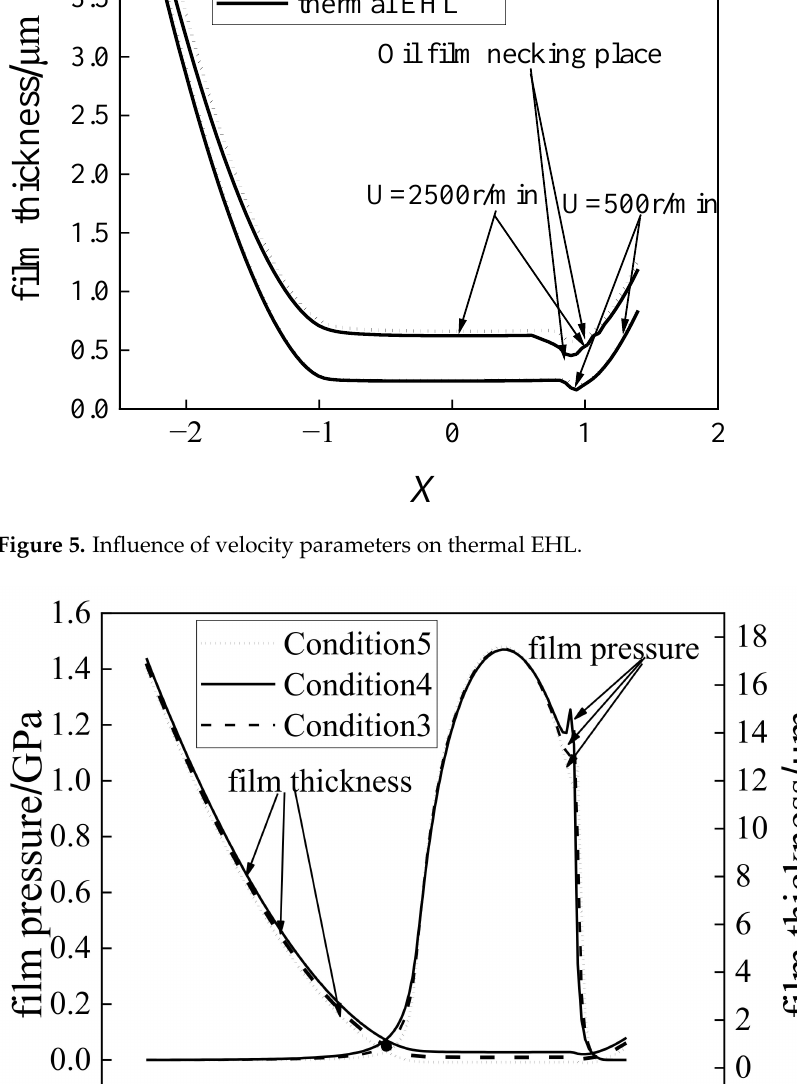
W = 12k N W = 3k N Figure 4. Effect of Radial Load on Oil Film Pressure Distribution. 4.1.2. Influence Analysis of Velocity Parameters Figure 5 shows the distribution of oil film pressure and film thickness in the X di- rection of the roller consisting of the largest load on the outer ring of the cylindrical roller